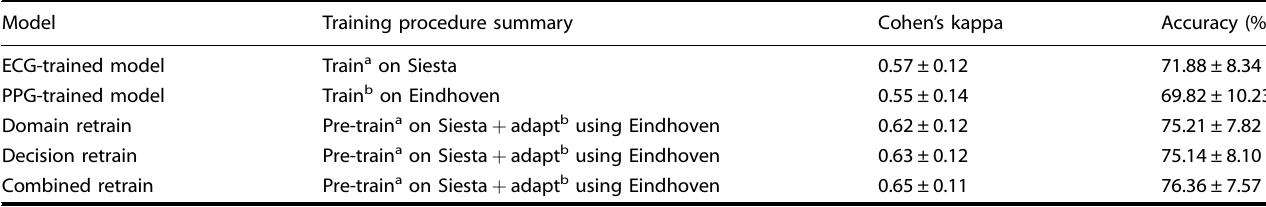
Table 2. Evaluation of different training strategies on the Eindhoven PPG data set. Model